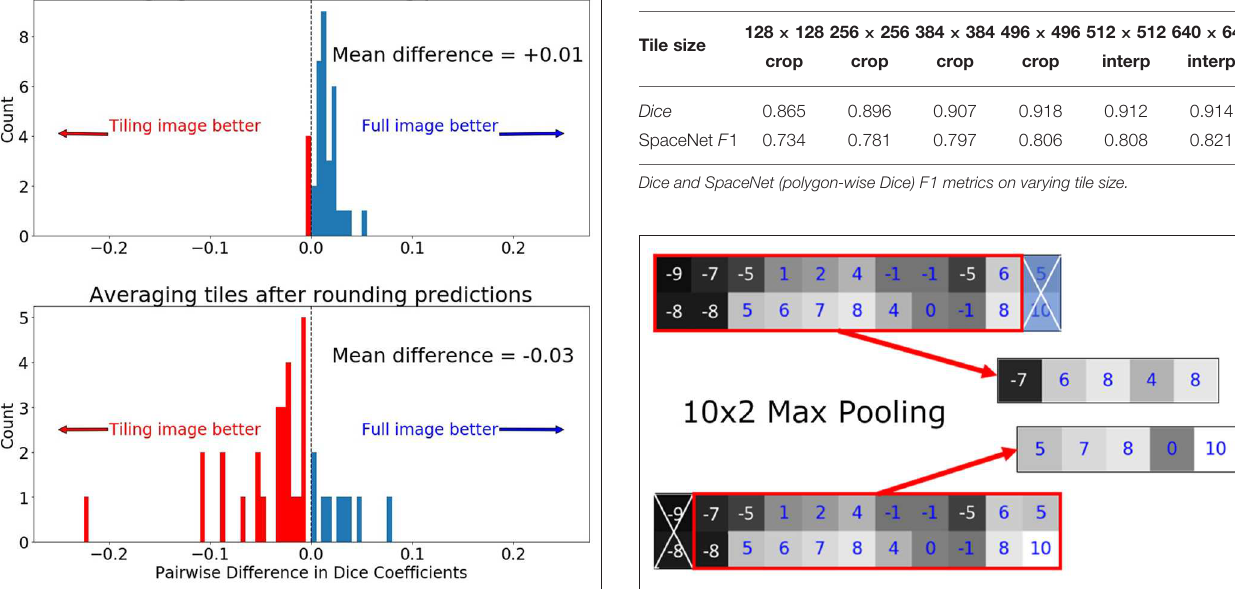
TABLE 4 | Results of 2D U-Net without zero-padding on non-medical data (SpaceNet Vegas).